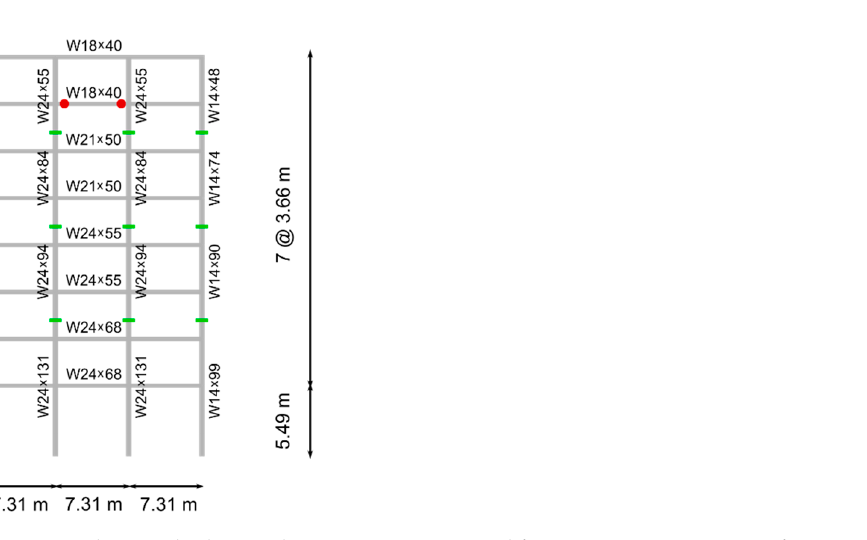
Figure 19. Realistic code-designed moment-resisting steel frame to assess seismic performance levels. Red dots denote selected plastic hinges. Green symbols indicate the section change at mid- story.